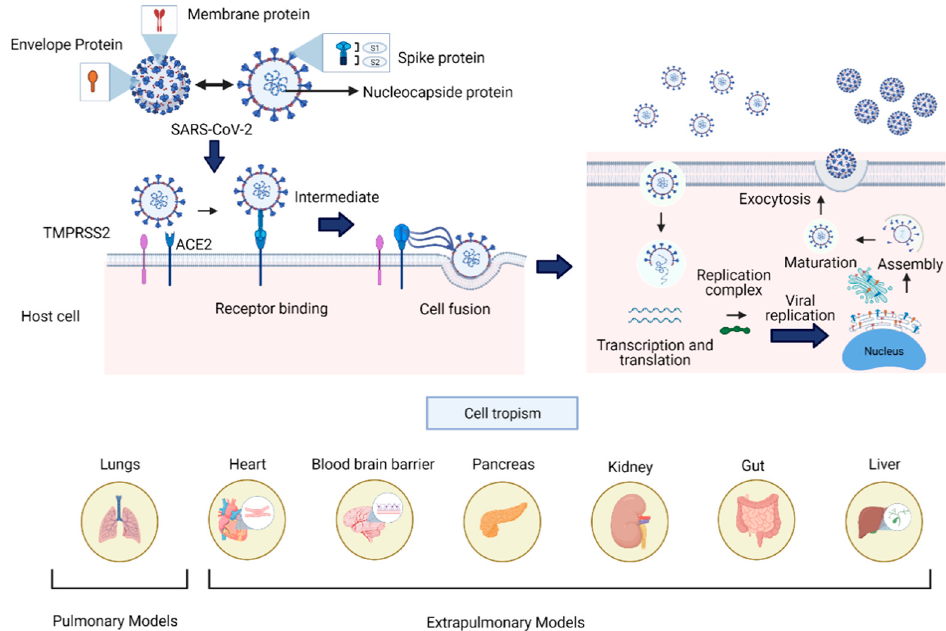
Figure 3. SARS-CoV-2 viral structure, infective cycle, and cell tropism. The structural proteins of SARS-CoV-2 comprise the S (spike), N (nucleocapsid), M (membrane), and E (envelop) proteins. For viral entry into the host cell, the spike protein interacts with the ACE2 and TMPRRS2 enzymes widely distributed in several human tissues. The infective cycle of SARS-CoV2 includes endocytosis mediated by the viral spike protein–ACE2 cell interaction. Once entering the cell, replicating and forming virions is achieved by the assembly and maturation of new viral particles and subsequent exocytosis. The lower panel shows the target organs previously developed to simulate viral infection processes. These 3D cell cultures resemble in vitro aspects of human pathophysiology, which are crucial to understand and address the current pandemic.